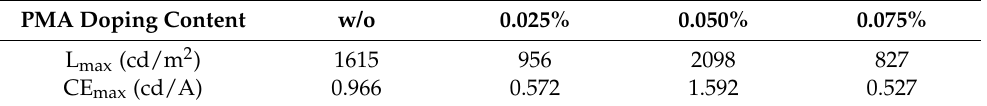
Table 1. Summary of the device parameters of PeLEDs with a different doping concentration of PMA. PMA Doping Content